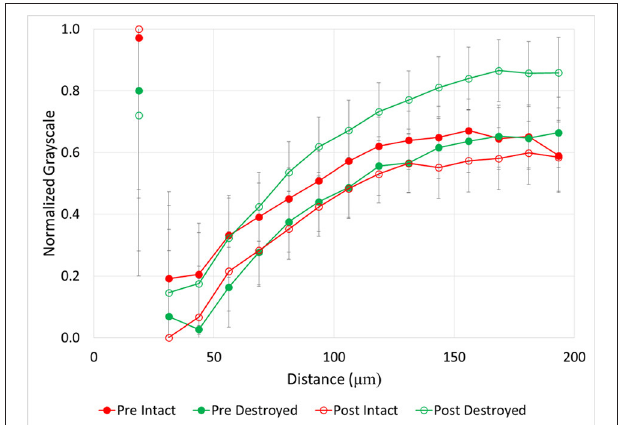
FIGURE 6 | Normalized grayscale values from µ CT images of soil fragments as a function of distance from 40 to 90 µ m pores for intact-structure and destroyed-structure at Pre and Post. Error bars indicate standard error. Note that values of the normalized grayscale reflect a combination of contributors, including atomic numbers of the elements and density of the material located within an image voxel. Specifically, lower normalized values here correspond to lower atomic number elements and lower densities, while higher values correspond to higher atomic number elements and higher densities. As such, lower values roughly represent more carbon in the soil matrix, while higher values represent less carbon in the soil matrix and/or denser soil matrix.